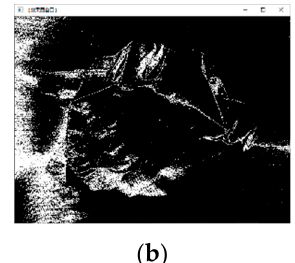
Figure 23. Obstacle and pothole. ( a ) The regular block obstacle; ( b ) the contour of the ground; ( c ) the contour of the block obstacle; ( d ) the regular pothole; ( e ) the contour of the ground; ( f ) the contour of the regular pothole.